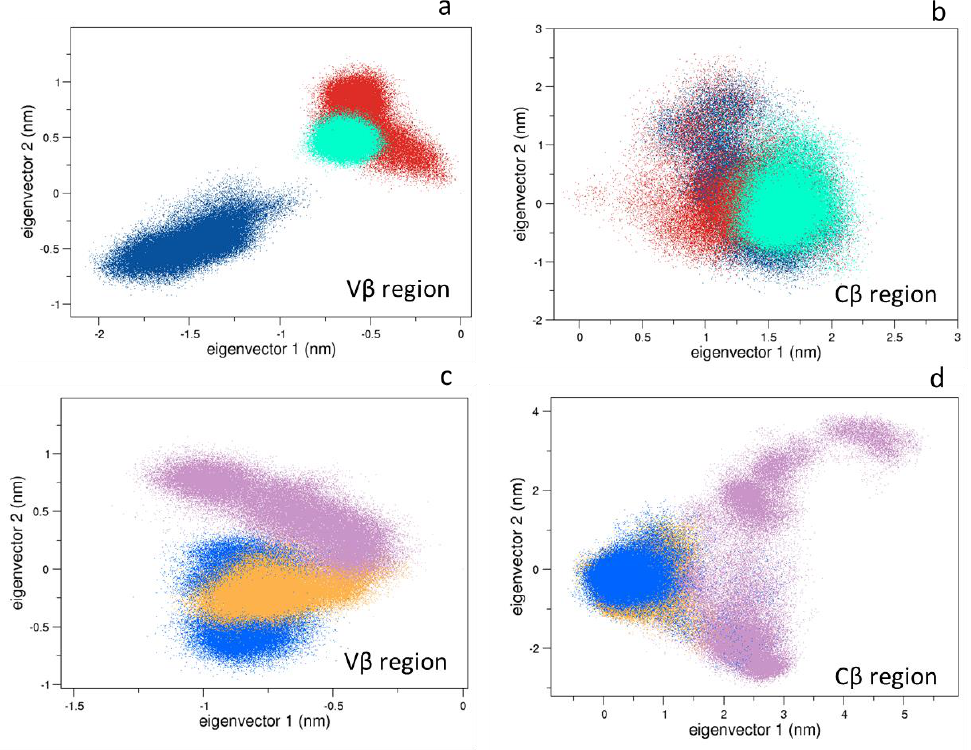
Figure 3. The 2D projections of bound-unbound states are shown. Panels ( a , b ): the projections of the MD trajectories of the 1G4 TCR on the 2D essential subspace (1G4-ESO9C in red, 1G4-ESO4D in cyan, unbound 1G4 in blue). Panels ( c , d ): the projections of the MD trajectories of the ILA1 α 1 β 1 TCR on the 2D essential subspace (ILA1 α 1 β 1-hTERT in orange, ILA1 α 1 β 1-hTERT-6A in blue, unbound ILA1 α 1 β 1 in mauve).